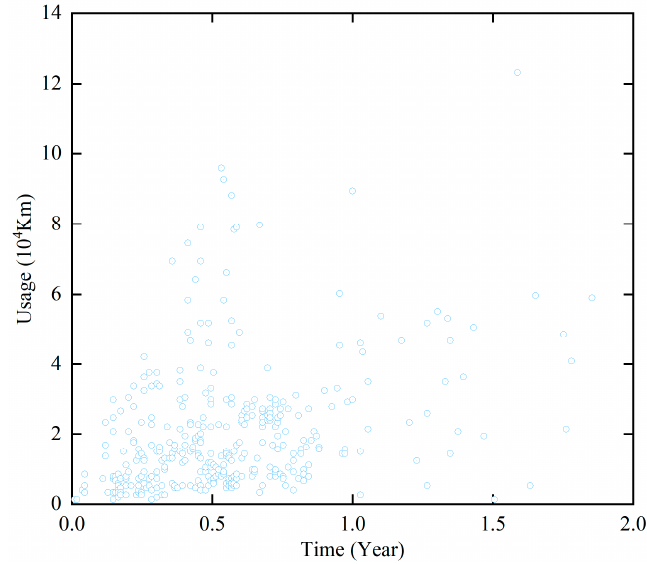
Figure 6. Scatter diagram of failure distribution.